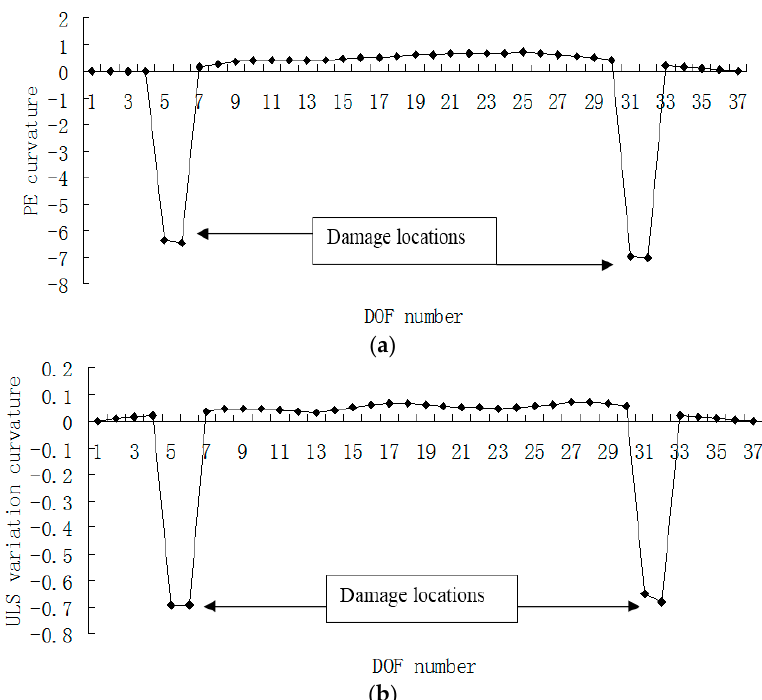
Figure 12. ( a ) Damage index (PE curvature) map using the first four exact modes when the defects occurred in elements 5 and 31; ( b ) Damage index (ULS variation curvature) map using the first four exact modes when the defects occurred in elements 5 and 31 (×10 − 3 ).